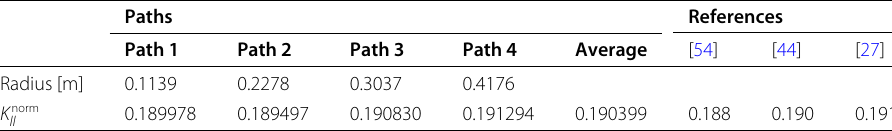
Table 2 Normalized SIFs, various J-integral paths